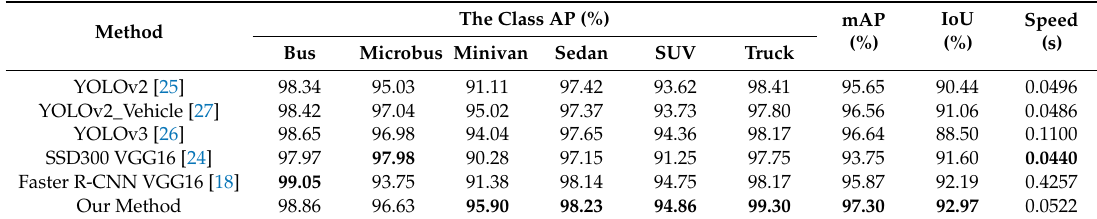
Table 1. Experimental results for different methods.